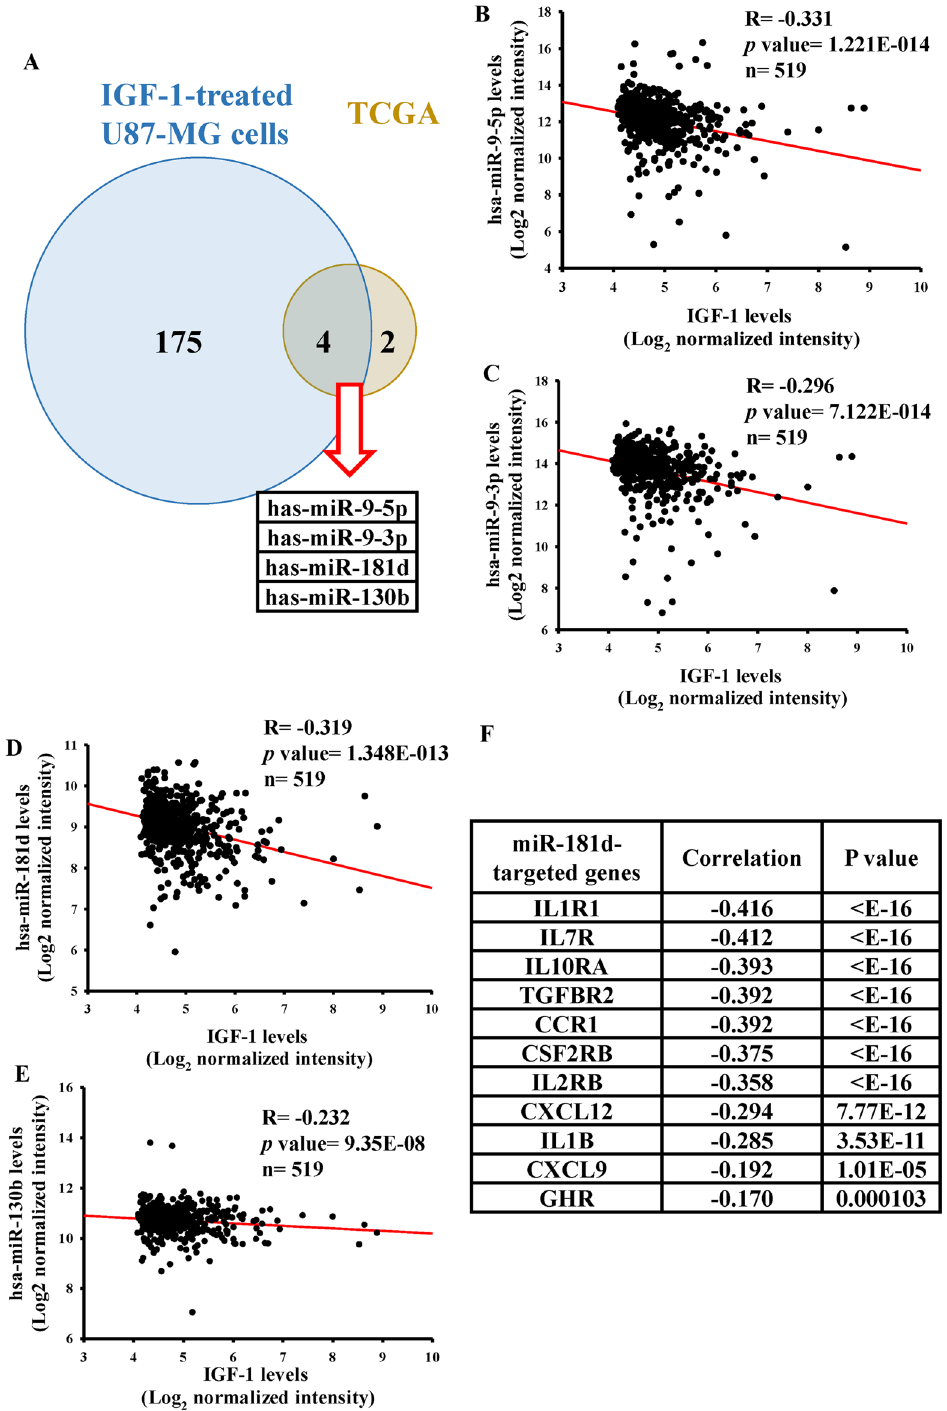
Figure 3. Identification of insulin-like growth factor (IGF)-1-mediated micro (mi)RNA signature by in silico and in vitro analyses. ( A ) The Venn diagram shows that four candidate miRNAs were identified in both TCGA miRNA array and IGF-1-treated U87-MG miRNA array data. Six and 179 IGF-1-downregulated miRNAs were respectively obtained from 312 TCGA miRNA arrays of GBM patients with different IGF-1 levels and the miRNA array analysis with 200 ng/ml IGF-1-treated U87 MG cells for 48 h (with a multiple of change (MC) of < 0.75 and a false discovery rate (FDR) of < 0.05). The four candidate miRNAs were identified in both miRNA array datasets. Expression correlations between IGF-1 and IGF-1-downregulated miRNAs included miR-9-5p ( B ), miR-9-3p ( C ), miR-181d ( D ), and miR-130b ( E ) in TCGA GBM data ( n = 519). The correlations were measured by Spearman’s correlation analyses. ( F ) The list shows 11 putative target genes of miR-181d with an inverse